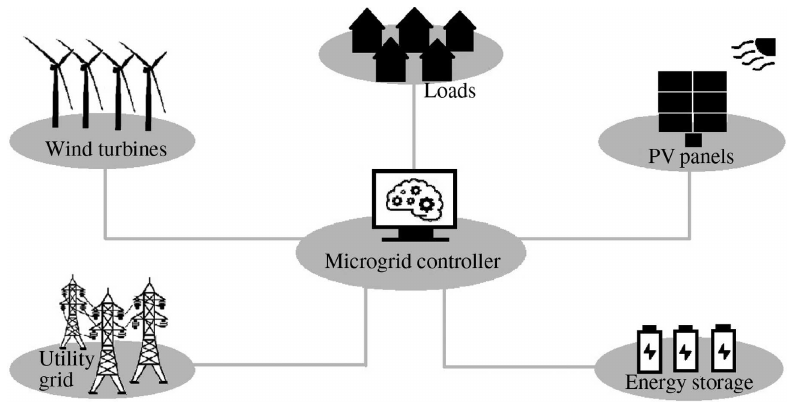
Figure 3: Diagram Overview of the Adopted MG with Renewable Energy